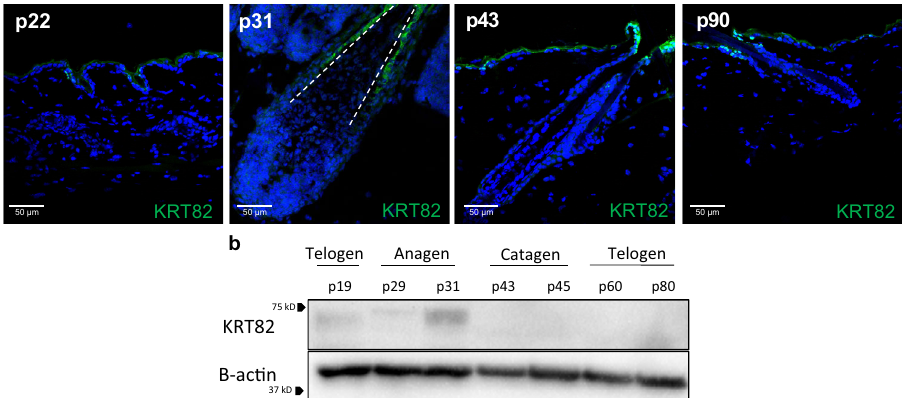
Fig. 6 KRT82 is expressed exclusively in anagen. a IF of KRT82 (green) in postnatal (p) mouse skin. Mouse HFs are in telogen at postnatal days 22 and 90 (p22, p90), in anagen at p31, and catagen at p43. Cuticular staining of KRT82 is only observed in the p31 (anagen) HF. White dashed line outlines the hair shaft cuticle. Weak staining observed in mouse epidermis may be a result of green auto fl uorescent properties of skin epidermal cells. IF staining was repeated at 3 other anagen timepoints and 2 additional telogen timepoints with similar results. b Western blot analysis of whole mouse skin at varying stages of the hair cycle shows that keratin protein is only present in the anagen phase (p31) of the mouse hair cycle. Western blot was repeated with similar results 2 additional times. Source data are provided as a Source data fi